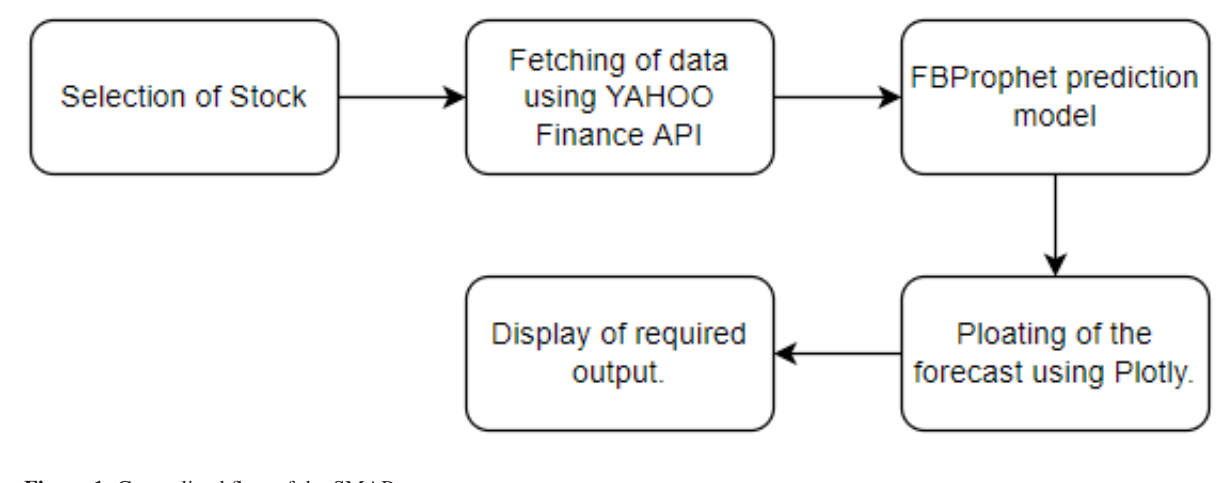
Figure 1. Generalized flow of the SMAP